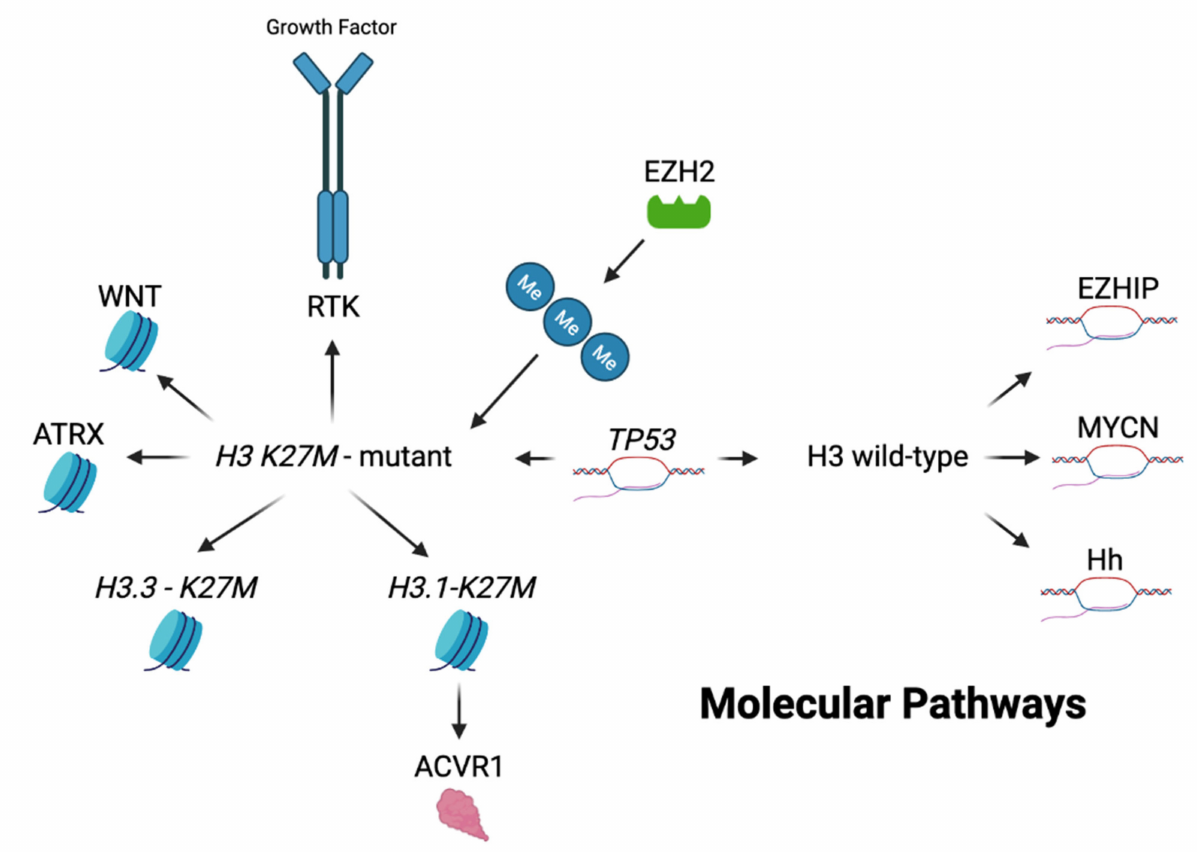
Figure 3. Genetic landscape of DIPG. Here outlines a brief overview of the genetic landscape and molecular pathways of H3 K27M -mutant and non-mutant pediatric gliomas. The H3 K27M